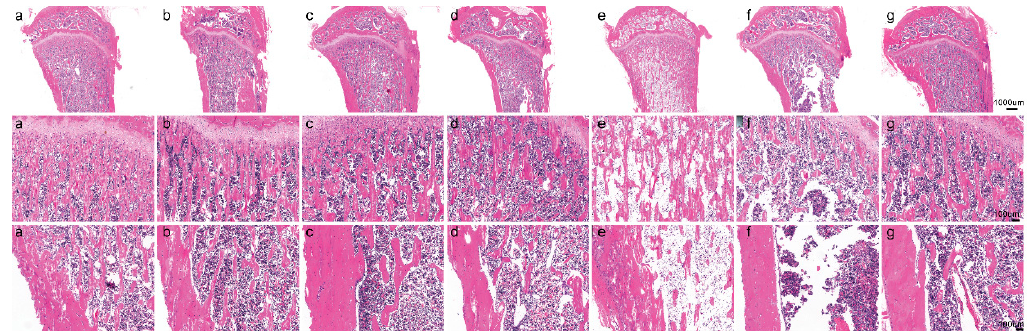
Figure 2. Representative HE staining of distal left tibia sections without Cd ( a ); with 1 mg Cd / kg diet Cd ( b ), with 1 mg Cd / kg diet plus Ca ( c ), 5 mg Cd / kg diet ( d ), 5 mg Cd / kg diet plus Ca ( e ), 50 mg Cd / kg diet ( f ), and 50 mg Cd / kg diet plus Ca ( g ). The trabecular number and cortical thickness decreased and that the trabecular separation increased in d, f groups. Ca supplementation led to a significantly increased in trabecular number and cortical thickness ( e , g ). But there were no significant di ff erences in exposure to the 1 mg Cd / kg diet with ( c ) or without Ca supplementation ( b ).